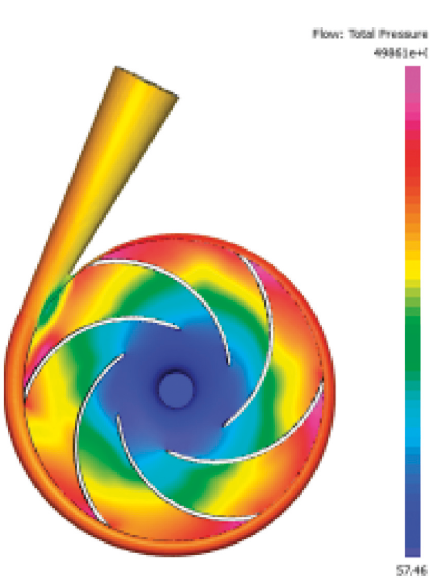
Figure 6: Overall pressure distribution.